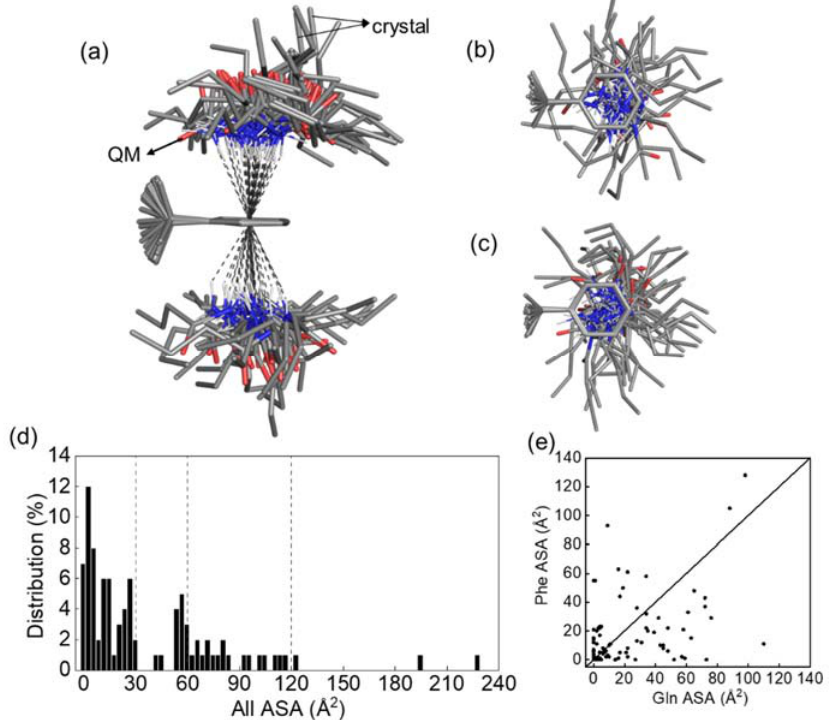
Figure 4. Q ‐ F pairs with a typical NH– π interaction extracted from the non ‐ redundant dataset of Figure 4. Q-F pairs with a typical NH– π interaction extracted from the non-redundant dataset of protein crystal structures. ( a–c ) The Q ‐ F pairs are positioned by superimposing Phe with each protein crystal structures. ( a – c ) The Q-F pairs are positioned by superimposing Phe with each other. other. The side, bottom ‐ up, and top ‐ down views are shown in ( a ), ( b ) and ( c ), respectively. ( d–e ). The side, bottom-up, and top-down views are shown in ( a ), ( b ) and ( c ), respectively. ( d,e ). Accessible Accessible surface (ASA) of the Q ‐ F pairs were calculated. Distribution of the total ASA is shown surface (ASA) of the Q-F pairs were calculated. Distribution of the total ASA is shown in ( d ). The in ( d ). The scatter plot of ASA of Gln vs. Phe is shown in ( e ). scatter plot of ASA of Gln vs. Phe is shown in ( e